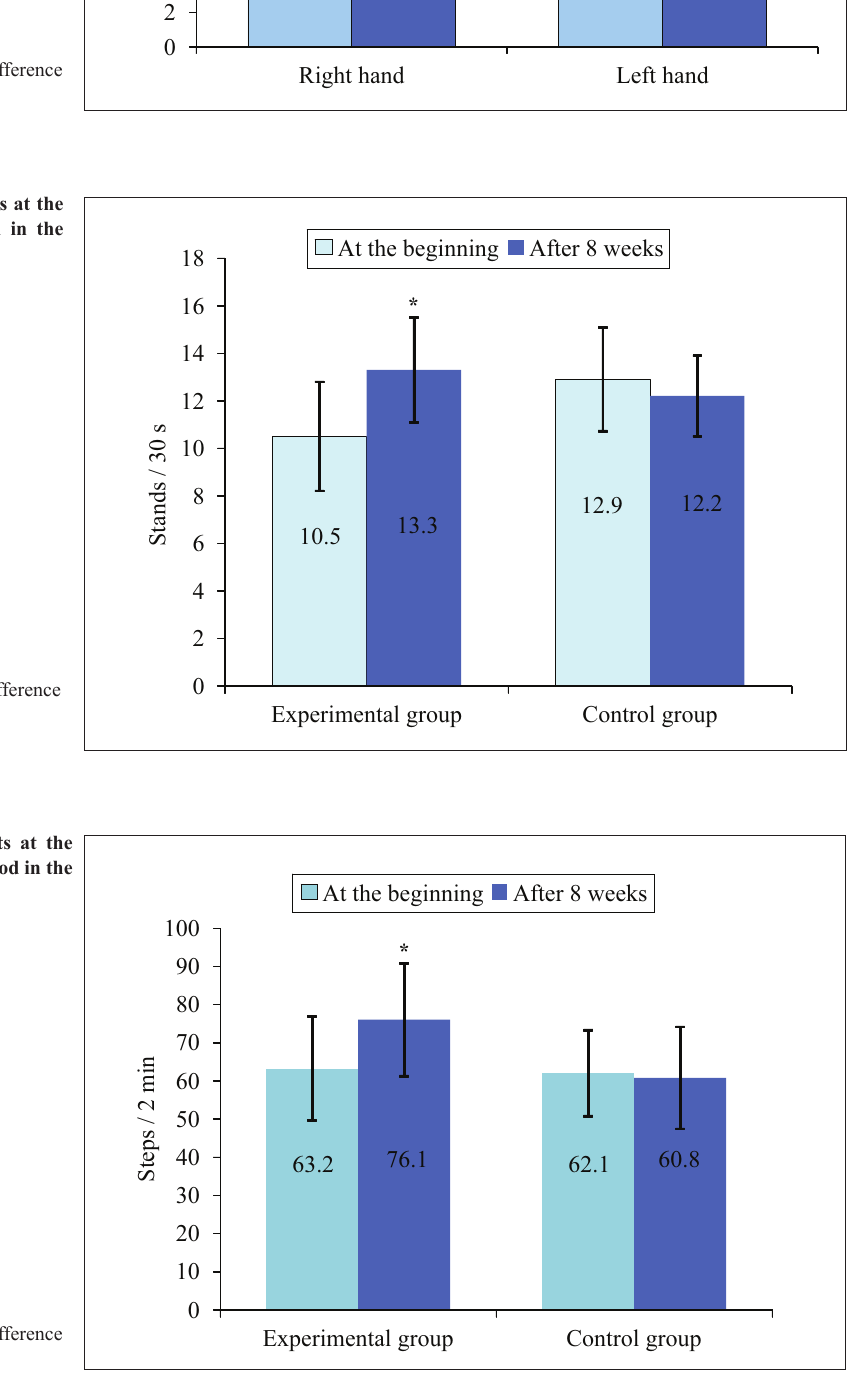
Figure 5. 2-minute step test results at the beginning and after an 8-week period in